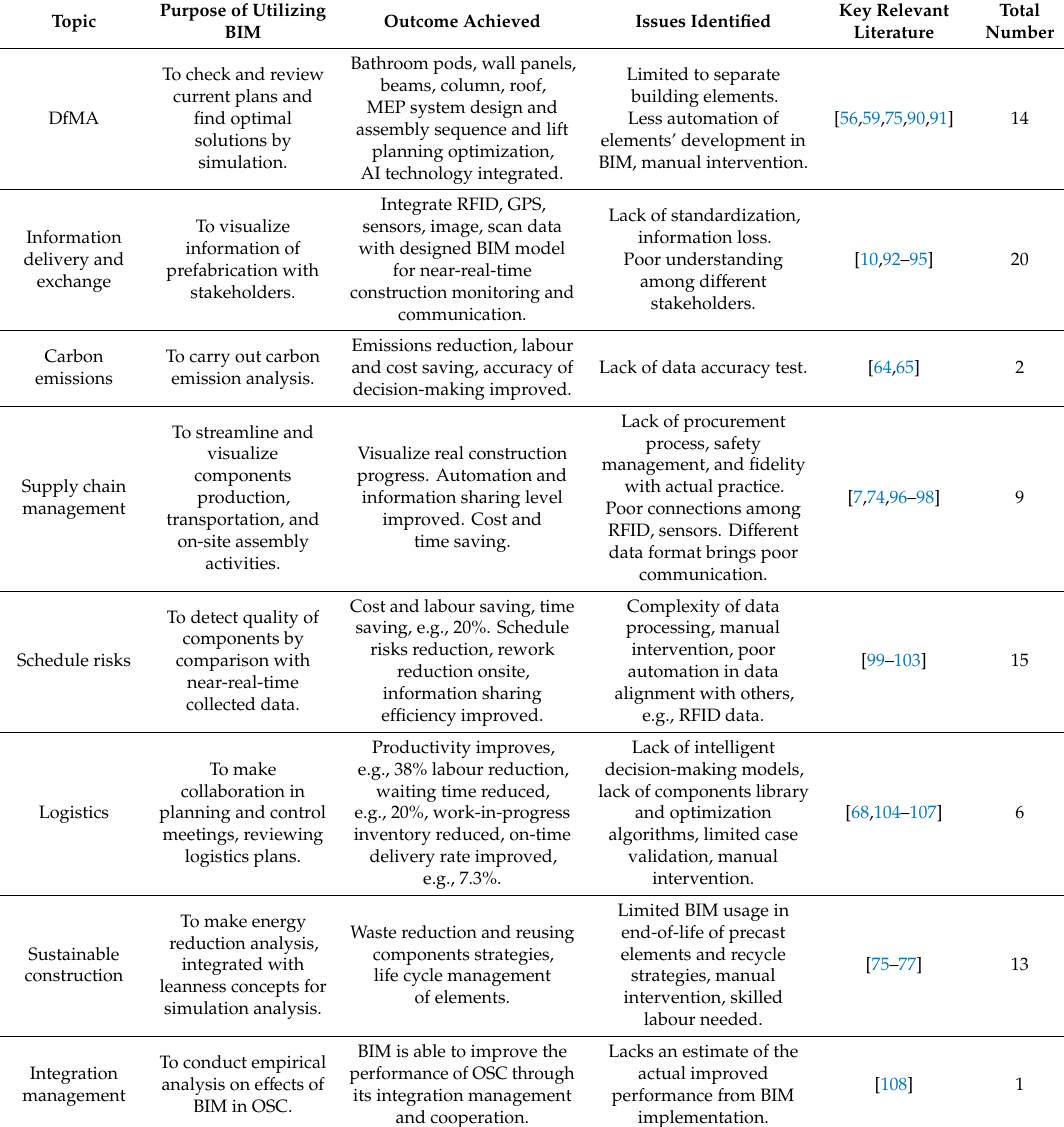
Table 4. Research topics, purpose of BIM adoption, and outcomes achieved in previous